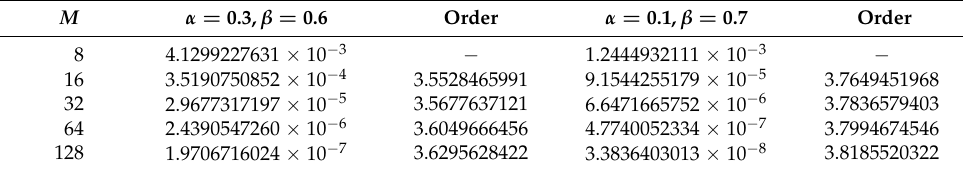
Table 5. Maximum errors and decay rate with N = [ M ( 4 − α ) / ( 4 − β ) ] . M